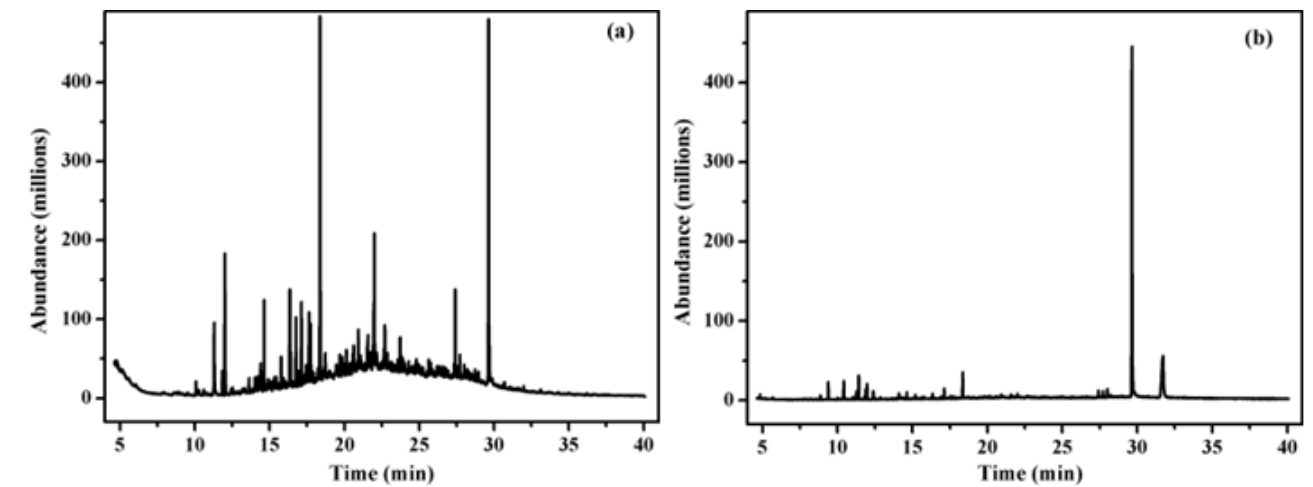
Figure 5. GC–MS analysis for organics in the influent ( a ) and effluent ( b ) of the electrochemical reactor.